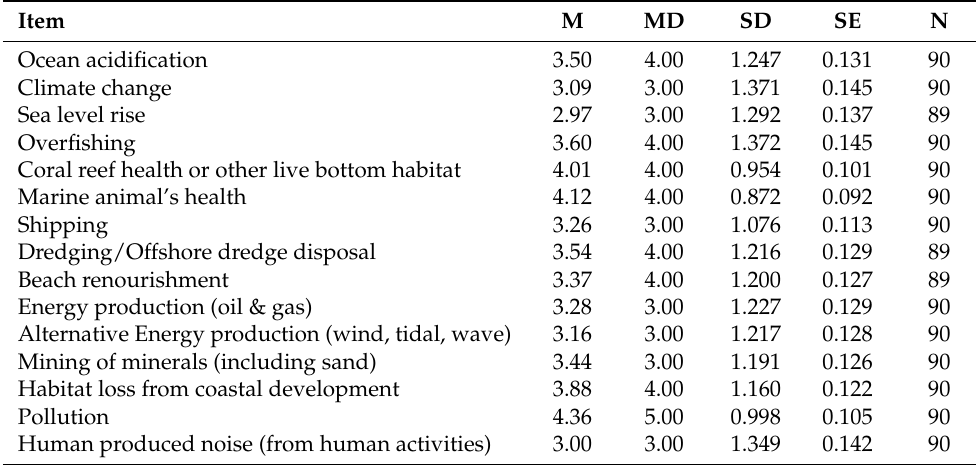
Table 3. Respondents’ Concern Levels of Ocean Resources Outside GRNMS.